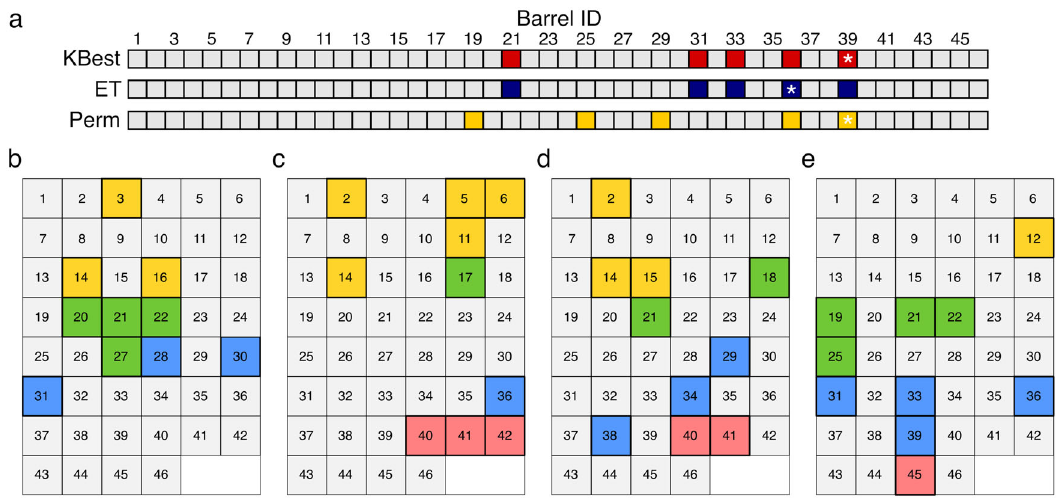
Fig. 5 | Features/ α HBs that contribute most to the α SA signal for different classi fi cations. a Feature importance of the 46 α HBs in the α SA in the differ- entiationofNASHandnon-NASHserasamples.Thetop5featuresasdeterminedby KBest analysis, ExtraTrees (ET) and permutation (perm) analysis are highlighted (red, blue and gold, respectively). The highest ranked α HB from each feature